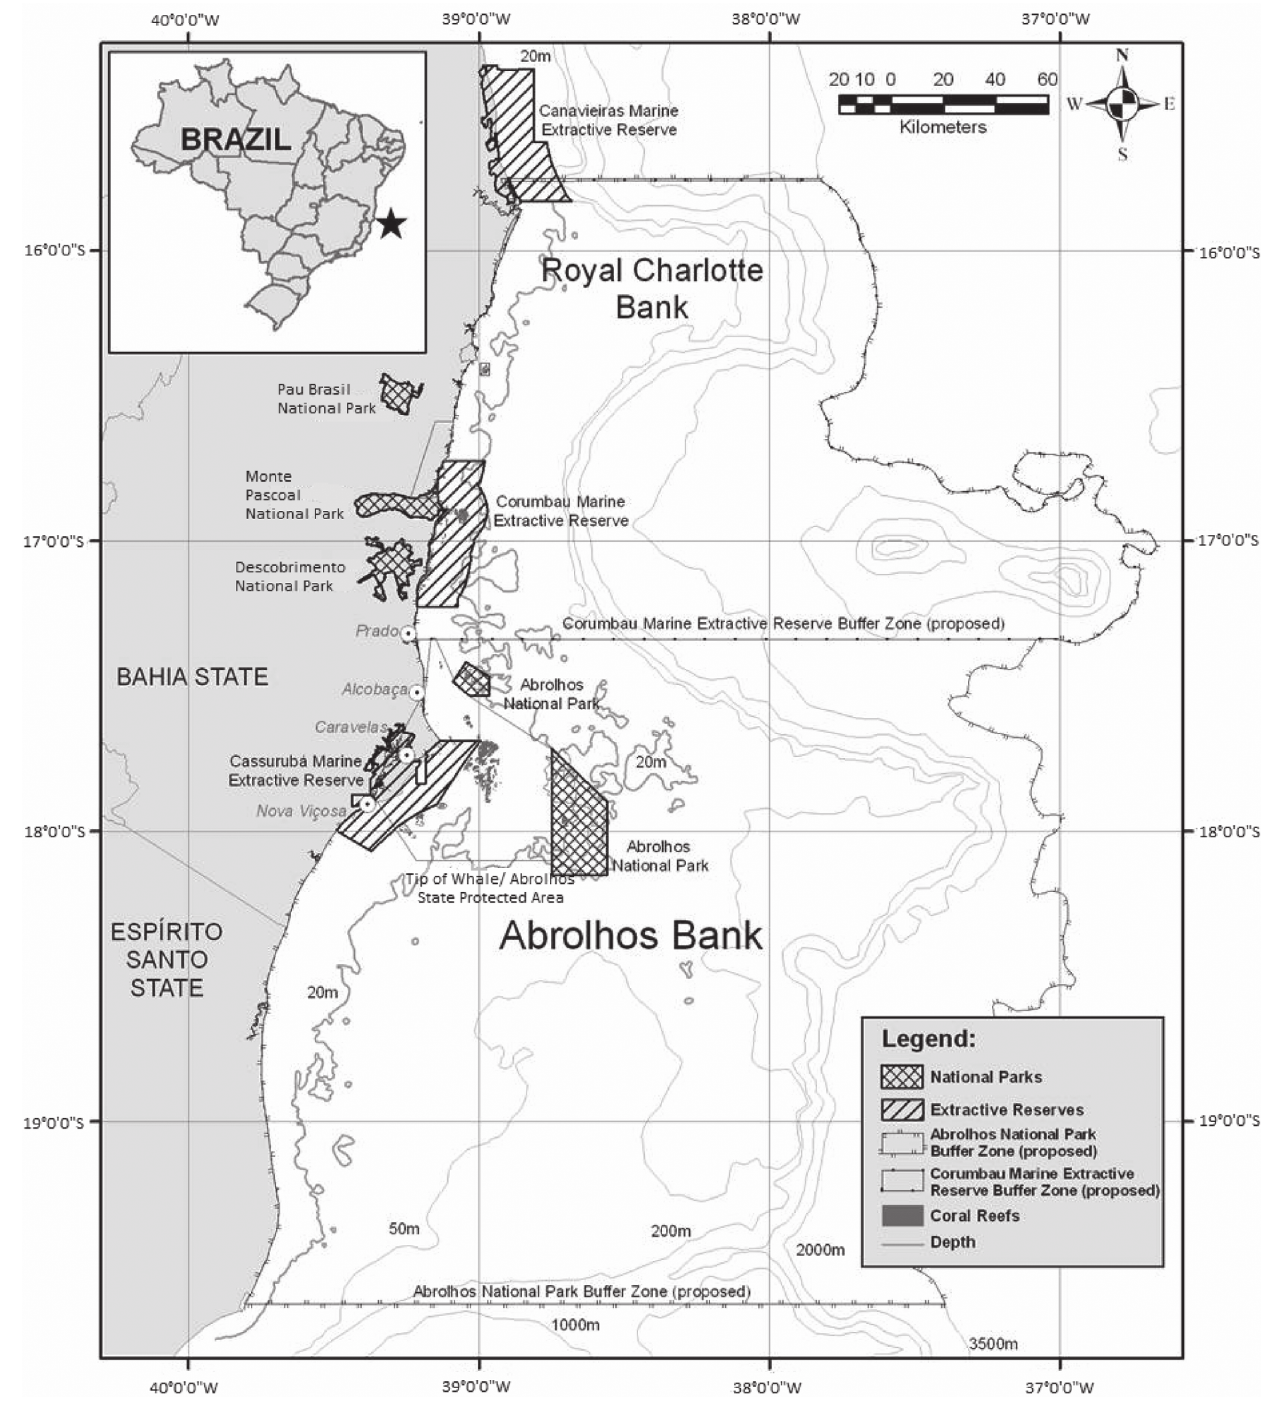
Fig. 1. Abrolhos Bank, Northeastern Brazil, showing the marine protected